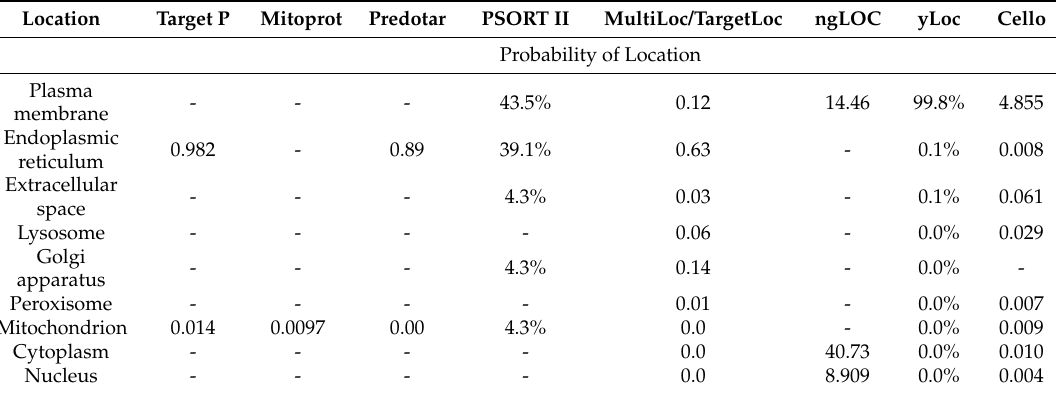
Table 1. Subcellular localization of GLUT10 predicted by in silico